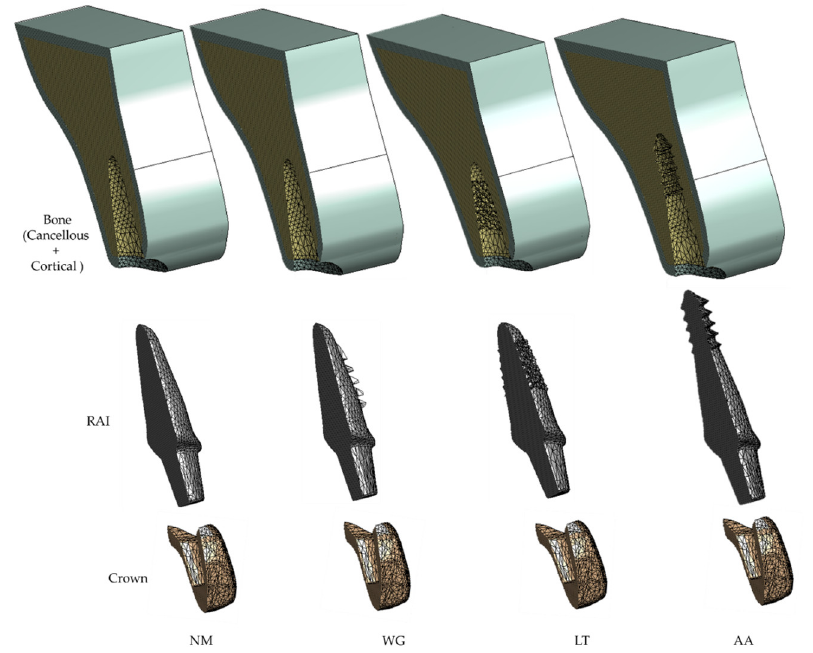
Figure 3. The sectional view of assembled root analogue implant (RAI) components of each experimental group. NM: group implanted with the non-modified surface designed RAI; WG: group implanted with the RAI with a wedge shape added at mesial and distal root surface; LT: group implanted with the lattice shape added at root surface RAI; AA: group implanted with the apex-anchor added RAI.